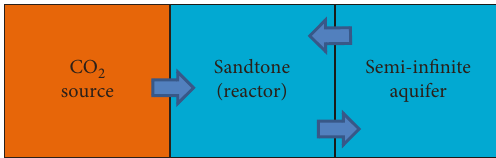
Figure 4: One-dimensional conceptual model of CO the Longtan sandstone